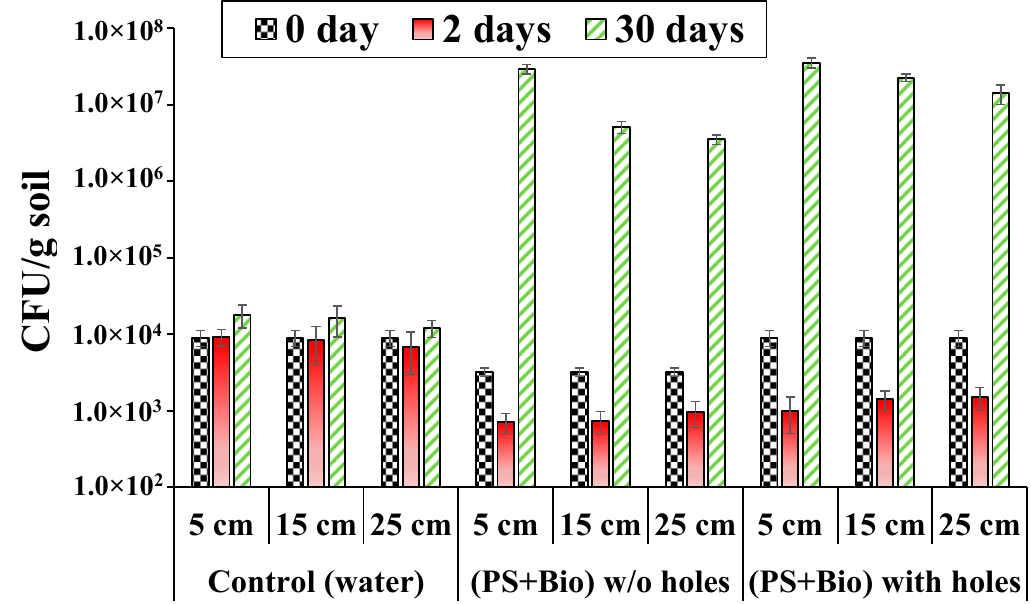
Figure 6. Change in soil microorganisms in three different soil depths (5, 15, and 25 cm from the surface) during persulfate oxidation and bioremediation of TPH.